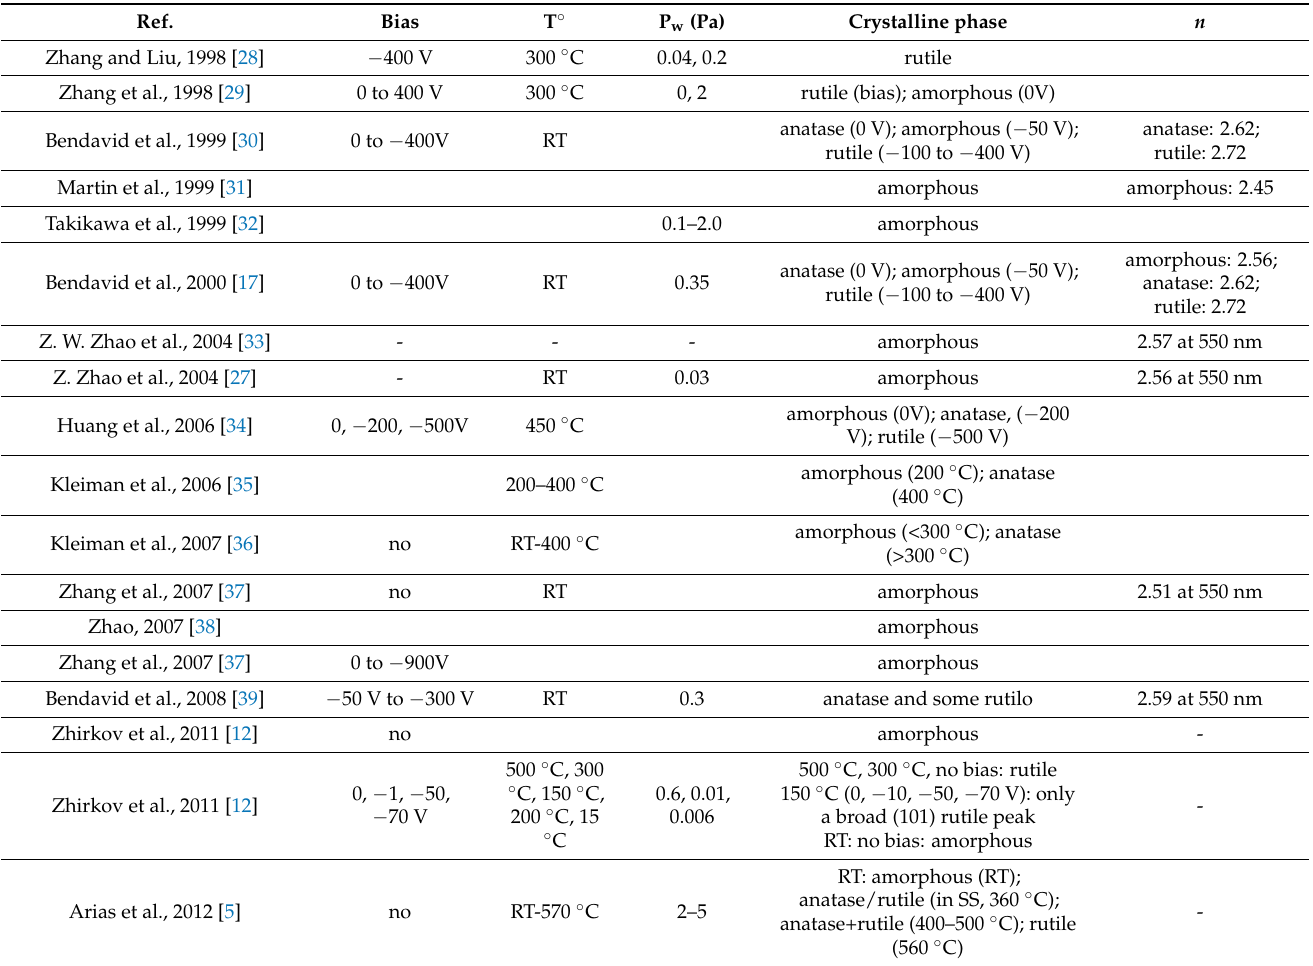
Table 3. Summary of previous references of TiO 2 films deposited using FCVA, including information about the applied bias, temperature and working pressure during deposition, the observed crystalline phase, and the refractive index. The results observed in the current work are included in the last row.